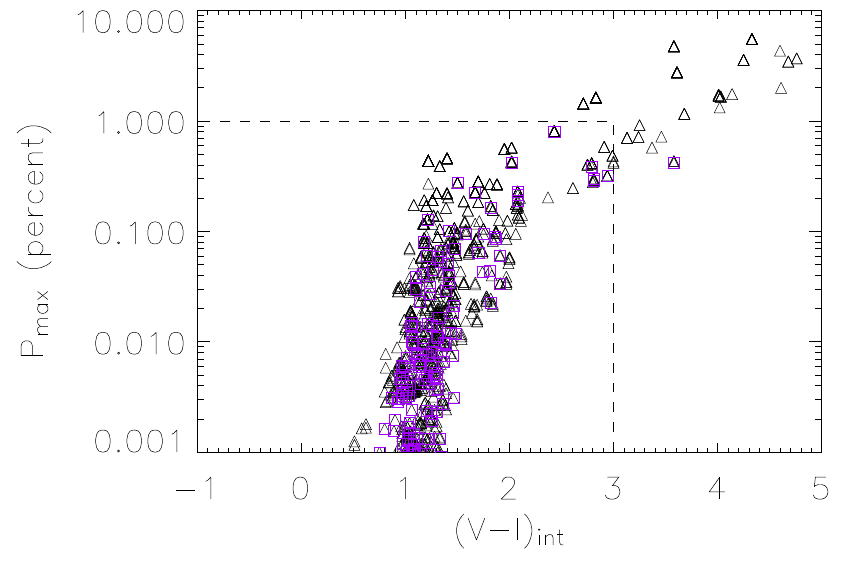
Figure 7. Distribution of the peak value of the polarization signal as a function of the intrinsic color index ( V − I ) int of the source star for simulated transit (triangles) and bypass (purple squares) events. The dashed lines indicate the region in which the events observed by the OGLECollaboration are expected to